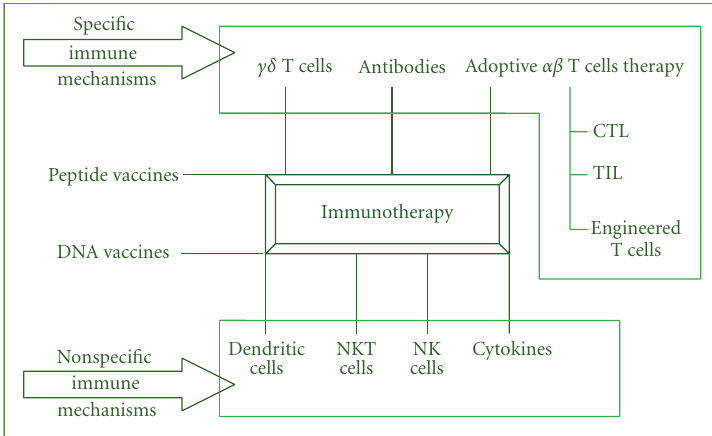
Figure 1: Di ff erent immunotherapeutic approaches.